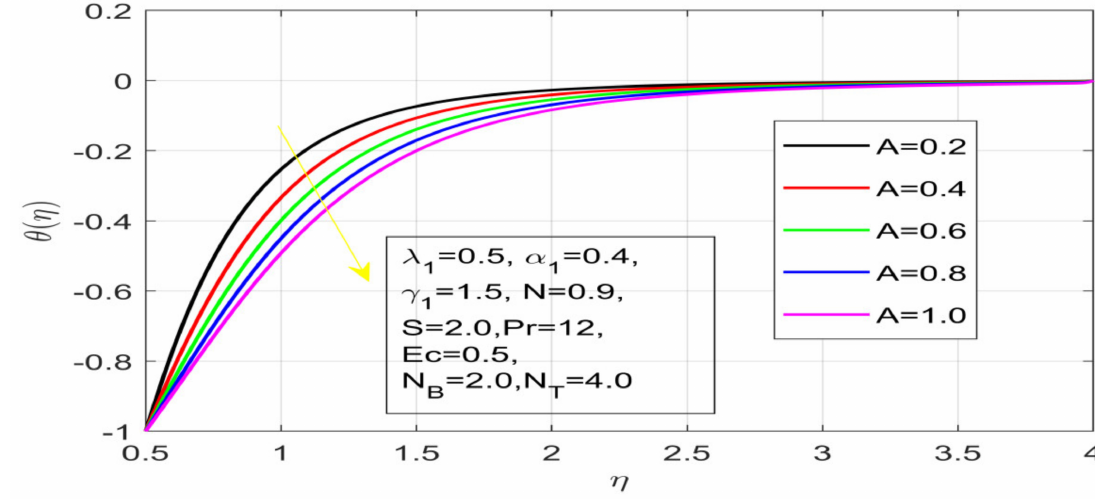
Figure 11. Effect of A on temperature.